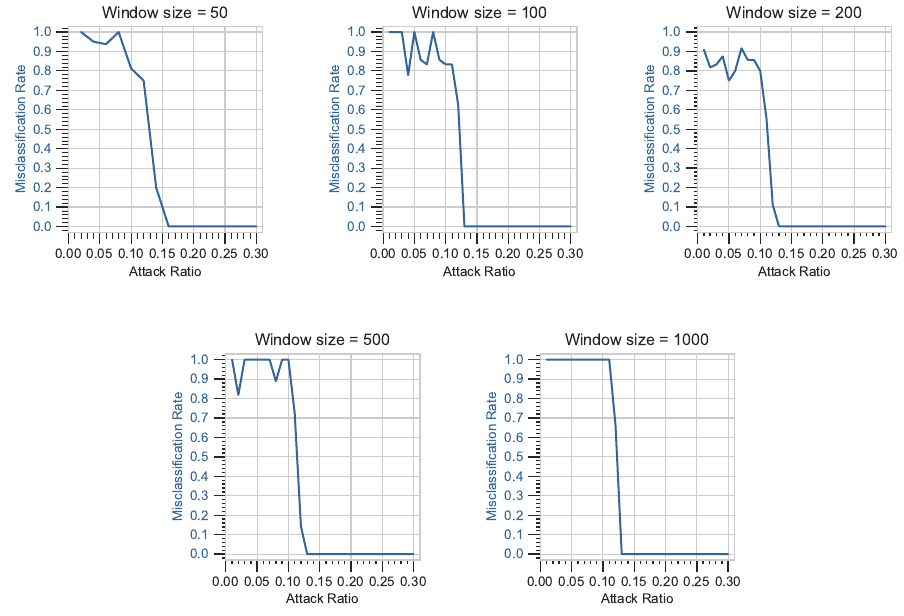
Figure 7. Attack ratio vs. misclassification rate for different window sizes (DoS